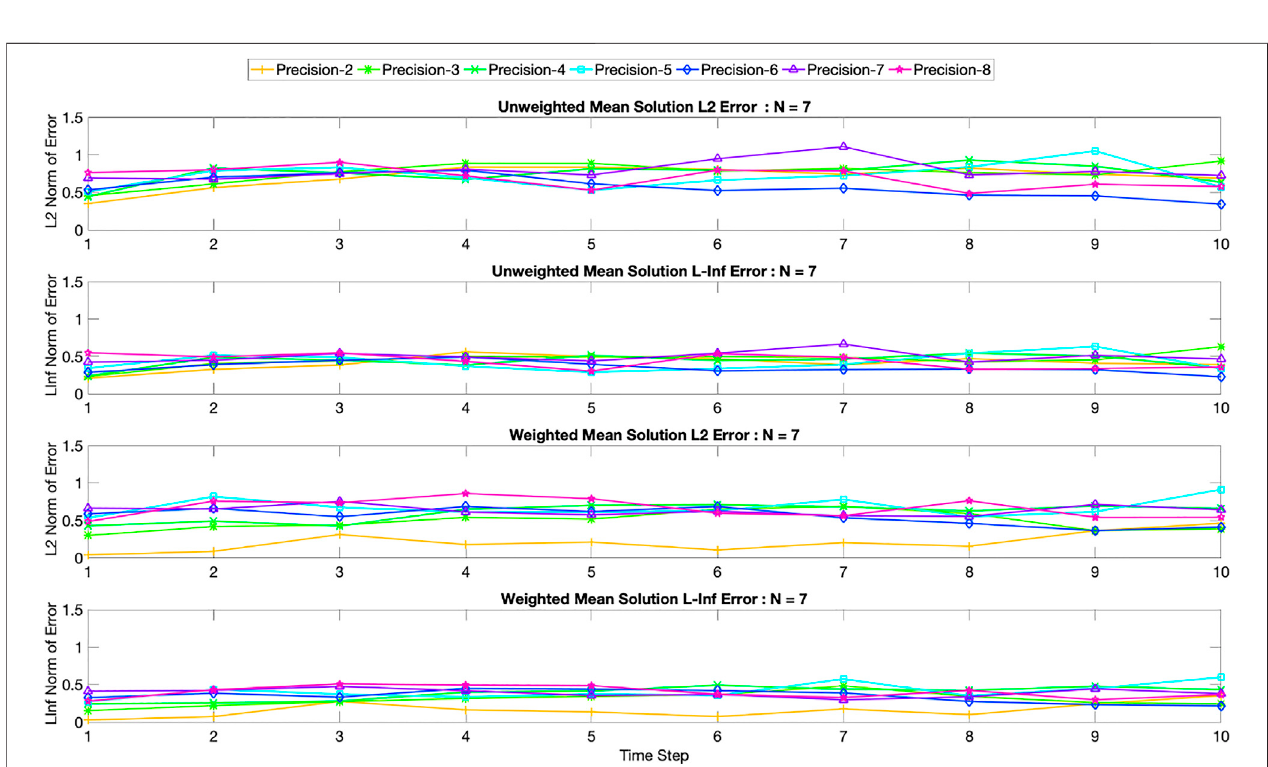
FIGURE 9 | L 2 and L ∞ errors of the unweighted and weighted mean solutions for a problem with seven grid points. The precision varies from 2 to 8 and the error is computed for each time step.